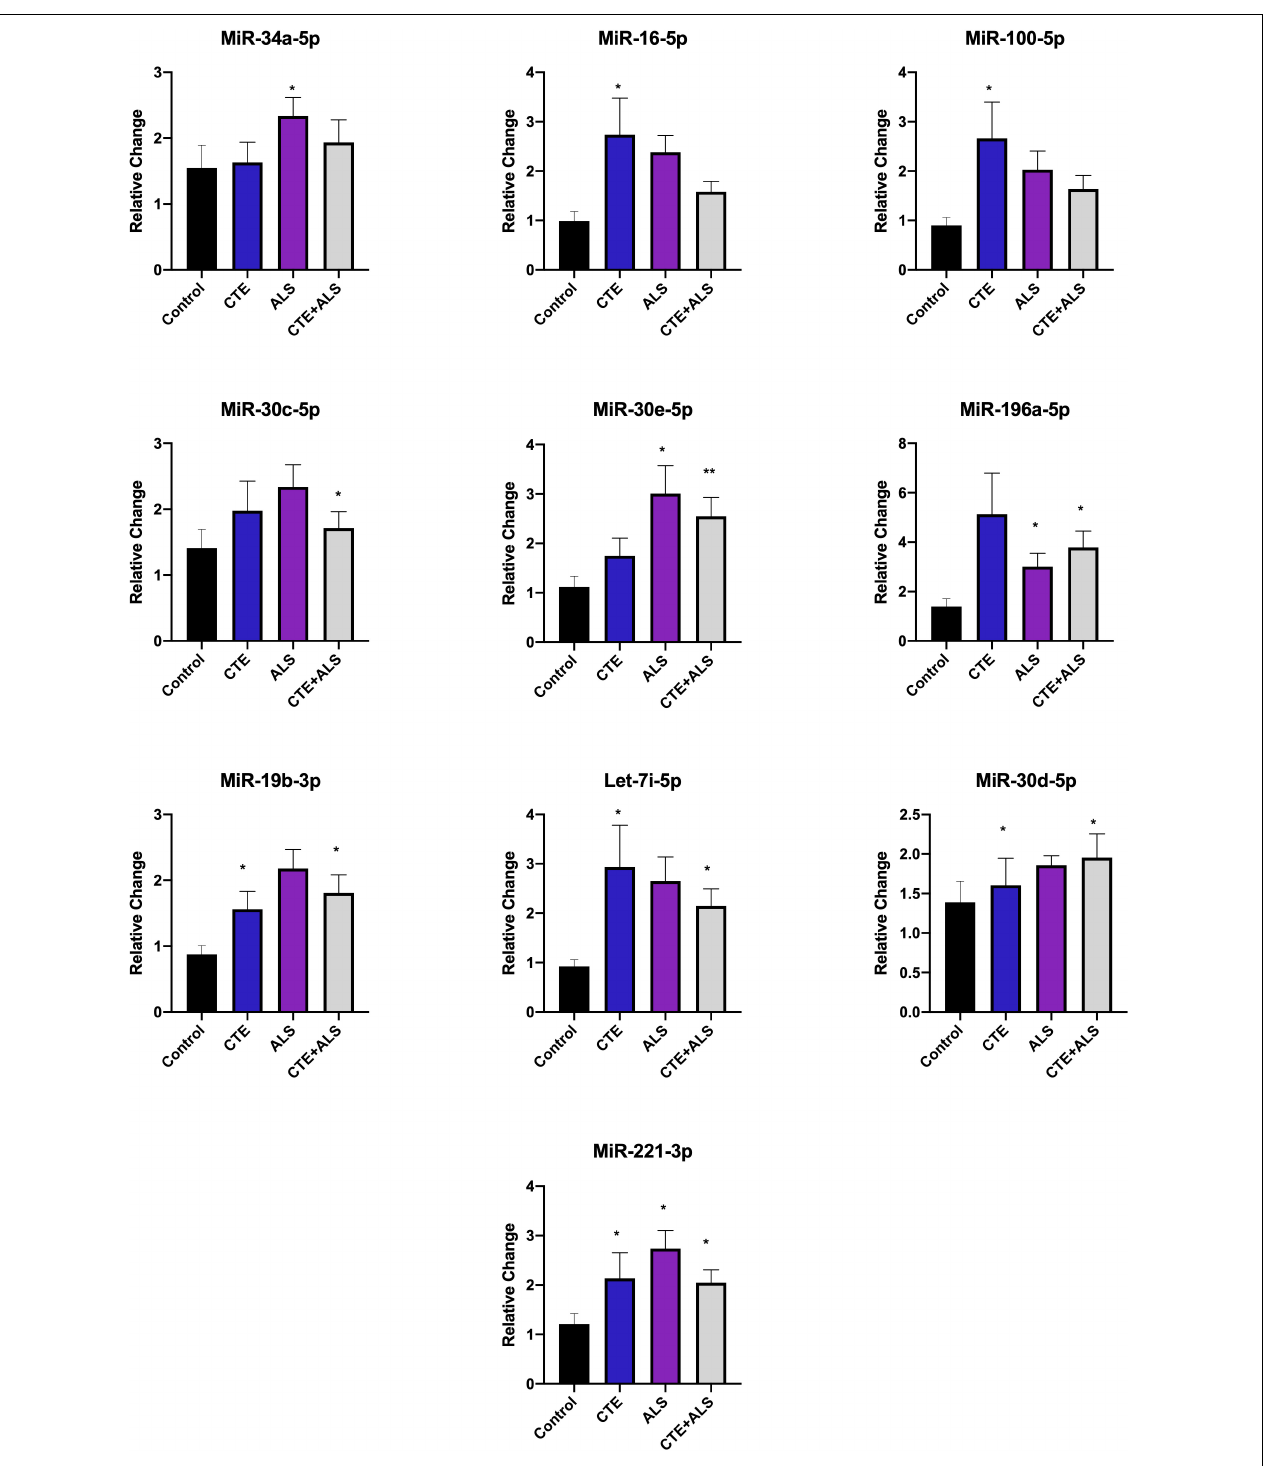
FIGURE 4 | Apoptotic miRNAs significantly altered in CTE, ALS, or CTE + ALS. MiR-34a-5p-5p was significantly upregulated in ALS alone. miR-16-5p and miR-100-5p were upregulated in CTE. MiR-30c-5p was upregulated in comorbid CTE + ALS. MiR-196a-5p and miR-30e-5p miRNAs were upregulated in both ALS and CTE + ALS. Let-7i-5p, miR-30d-5p, and miR-19-3p were upregulated in both CTE and CTE + ALS. Finally, miR-221-3p was upregulated in all three groups. Error bars denote standard error of the mean. * p < 0.05, ** p < 0.01 compared to control group. Refer to Table 3 for statistical analyses between the pathologic groups and the control